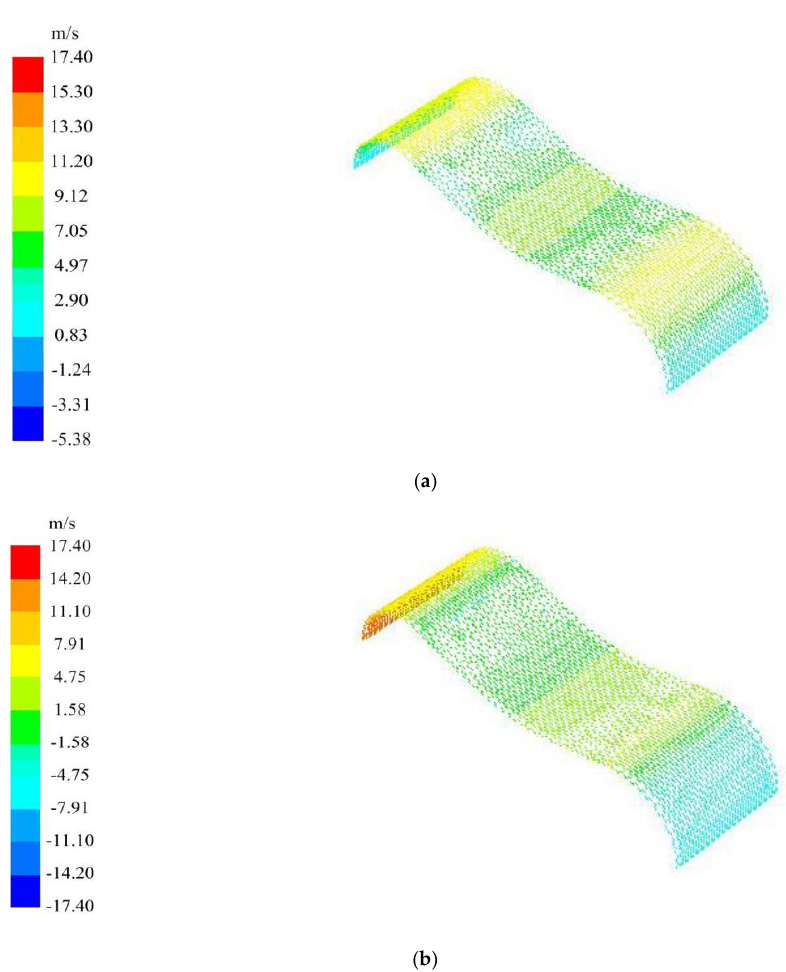
Figure 14. Velocity vectors of particles in the optimized flow passage: ( a ) X velocities of particles; and ( b ) Y velocities of particles.